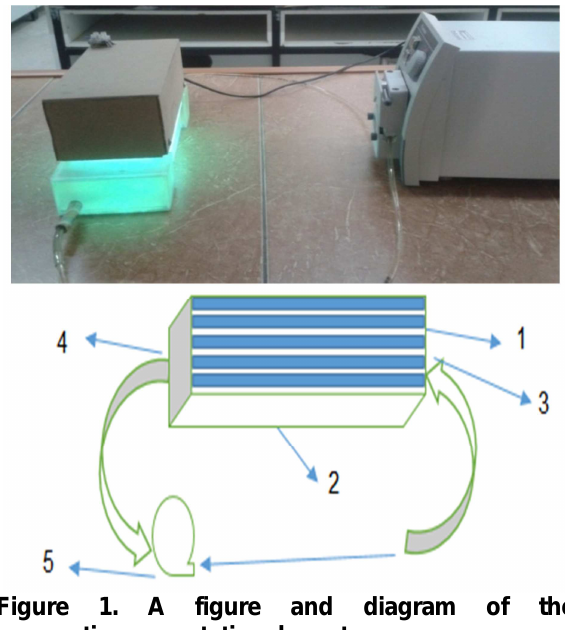
Figure 1. A figure and diagram of the noncontinuous rotational reactor 1. The reactor cover and the lamps attached to it; 2. The glass bed containing fixed zinc oxide nanoparticles; 3. Entry orifice; 4. Exit orifice; and 5. Peristaltic